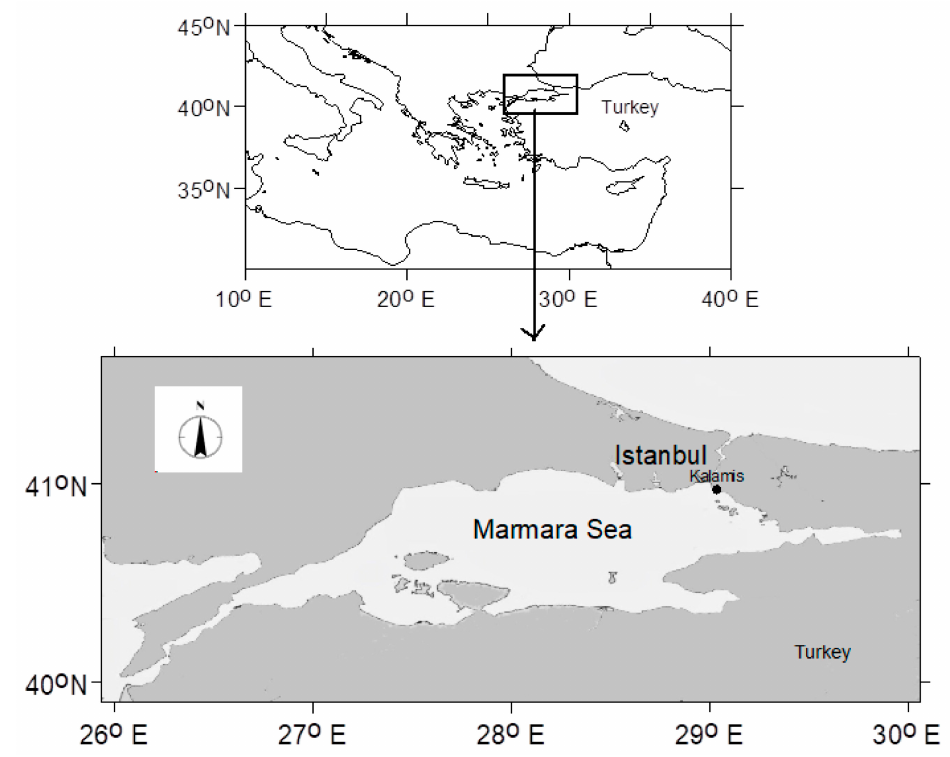
Figure 1. Sampling region for the coccolithophorid Ochrosphaera neapolitana in the Sea of Marmara on 11 June